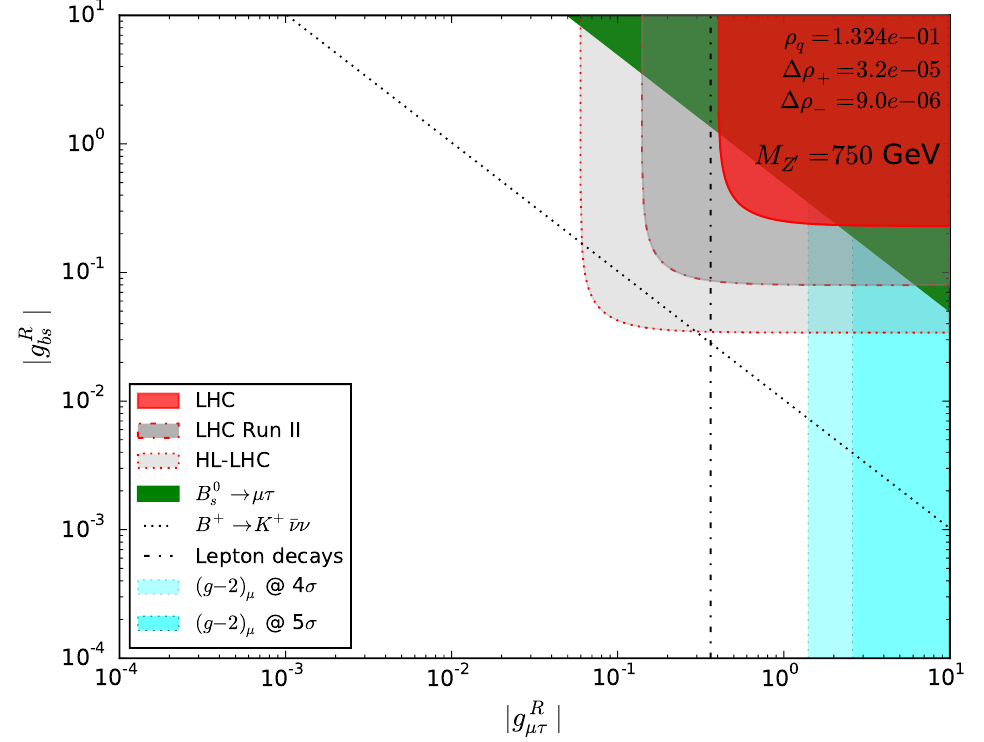
Figure 2 . The (cid:13)avor-violating couplings g R and g R for a Z 0 boson of M Z 0 = 750 GeV and a (cid:22)(cid:28) bs coupling ratio of (cid:26) q = g L =g R = 0 : 1324 (for an explanation of (cid:1) (cid:26) see section 3.1.1). The red area bs bs p indicates the limit from the ATLAS analysis of the process pp ! (cid:22)(cid:28) at s = 8 TeV. The red dash-dotted and dashed lines are projections to the LHC Run II and HL-LHC. The green area represents the excluded region from the decay B 0 ! (cid:22)(cid:28) . The black dotted line is the limit from s B + ! K + (cid:22) (cid:23)(cid:23) and the black dash-dotted line the limit from lepton decays. These last two limits, however, apply only for left-handed lepton couplings. The light and dark cyan areas depict the 4 and 5 (cid:27) exclusion bands from (cid:1) a (cid:22)